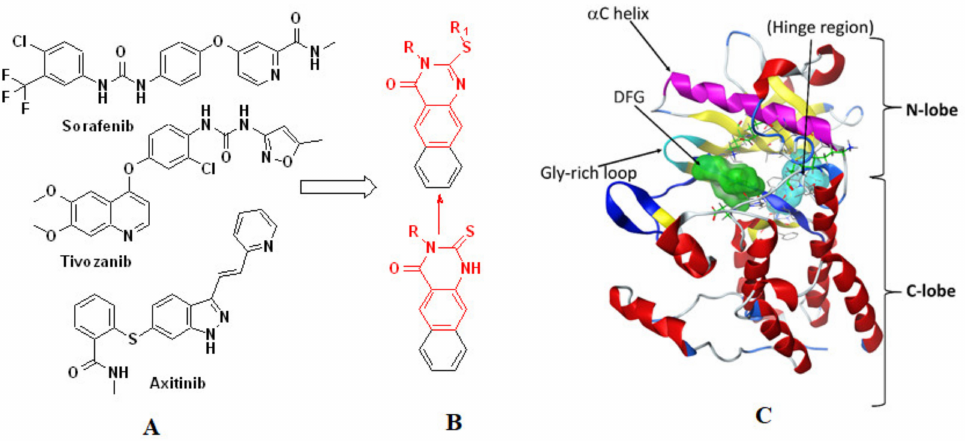
Figure 1. The reported VEGFR-2 inhibitors ( A ) the designed VEGFR-2 inhibitors ( B ) and the site for binding of ATP for VEGFR-2 catalytic domain ( C